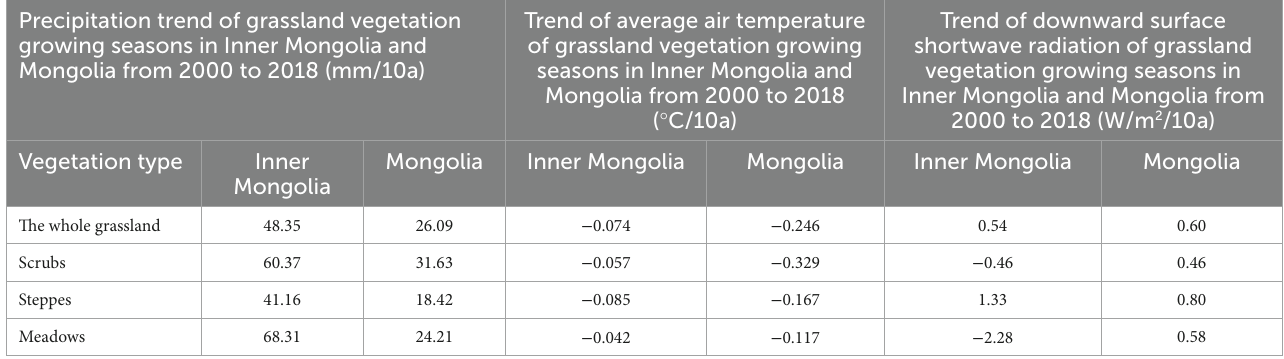
TABLE 3 Comparison of meteorological factors change trends of grassland vegetation types in Inner Mongolia and Outer Mongolia during growing seasons from 2000 to 2018. Precipitation trend of grassland vegetation growing seasons in Inner Mongolia and Mongolia from 2000 to 2018